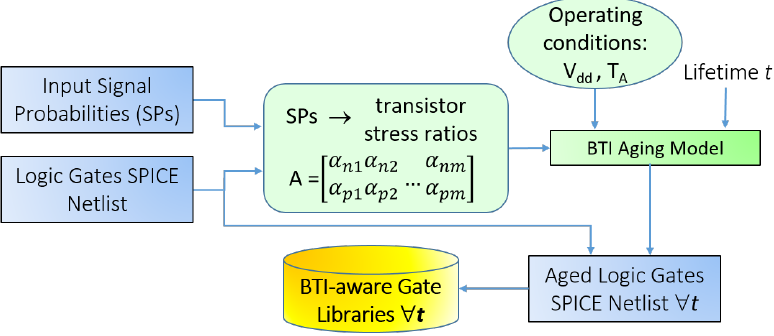
Figure 2. Flow for workload and operating condition-aware gate model characterization.